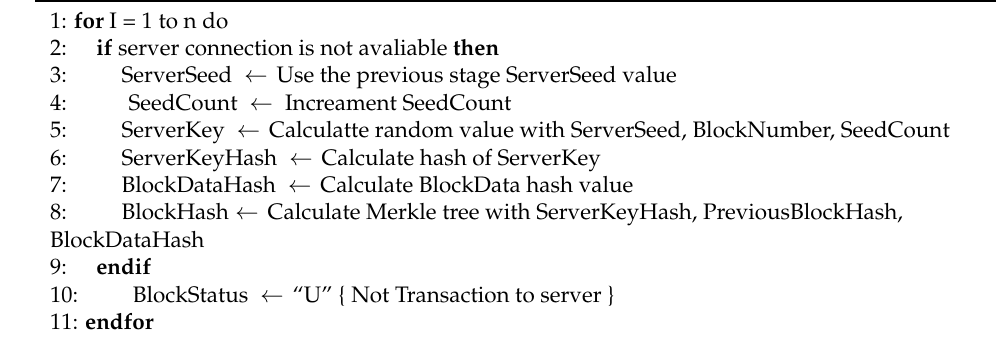
Table 3. Pseudo Code for Off-Line Process: Digital